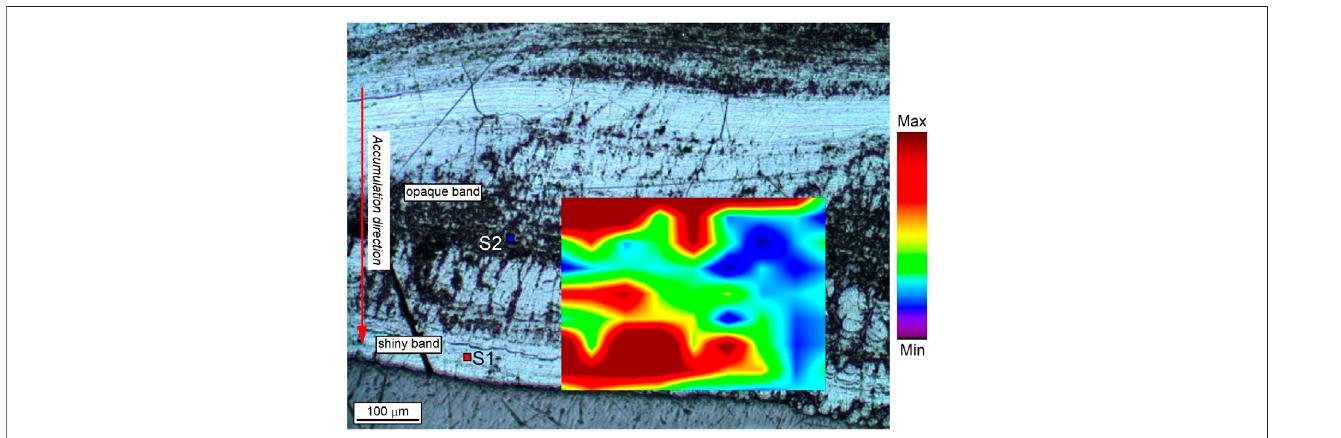
FIGURE 7 | Raman map of the oxidation state of Mn obtained by integrating the intensity ratio between the band at 630 cm − 1 ( ν 1 stretching mode of Mn 4+ - octahedra) and the band at 570 cm − 1 ( ν 1 stretching mode of Mn 3+ -octahedra) over the scanned area (see methods for details). Red/yellow: higher average oxidation state of Mn (todorokite and/or ranciéite in a shiny band), blue/green: lower average oxidation state of Mn (vernadite in an opaque band). S1 and S2 are the spots where Raman spectra of Figure 6 were obtained.